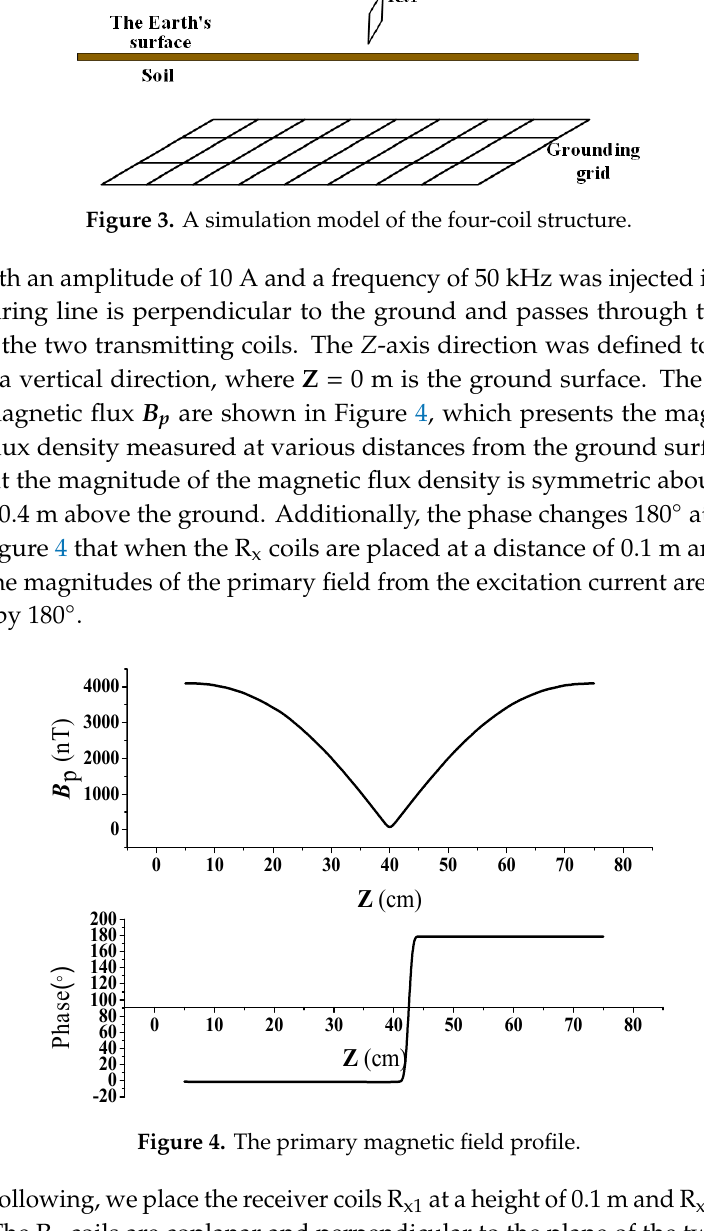
Figure 5. Grounding grid and survey area.